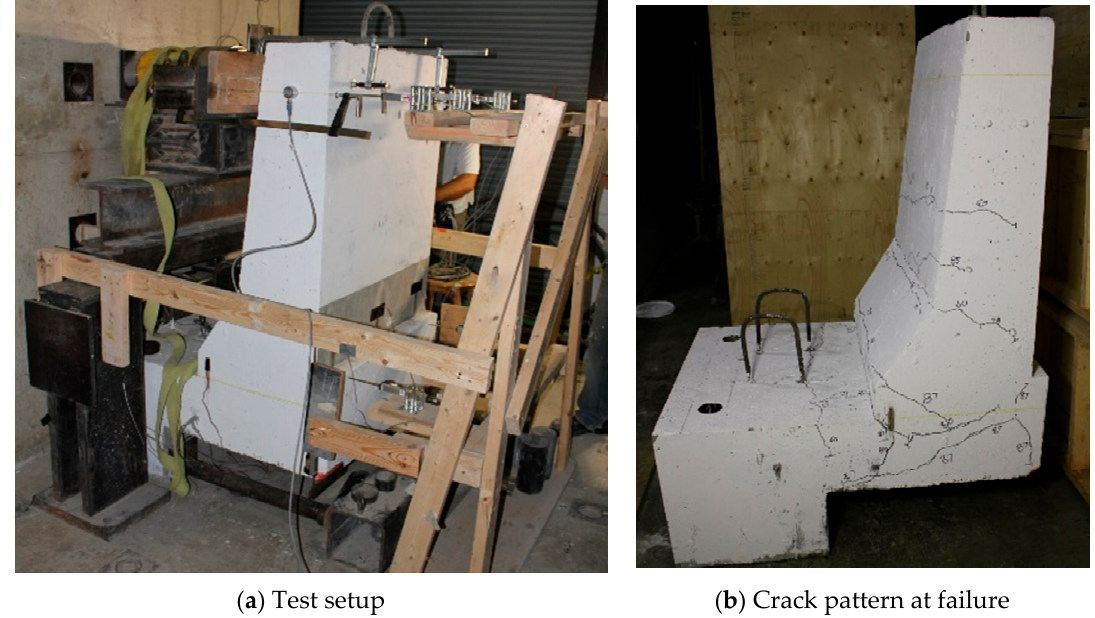
Figure 10. Specimen # 1 before and after testing. ( a ) Test setup; ( b ) crack pattern at failure.